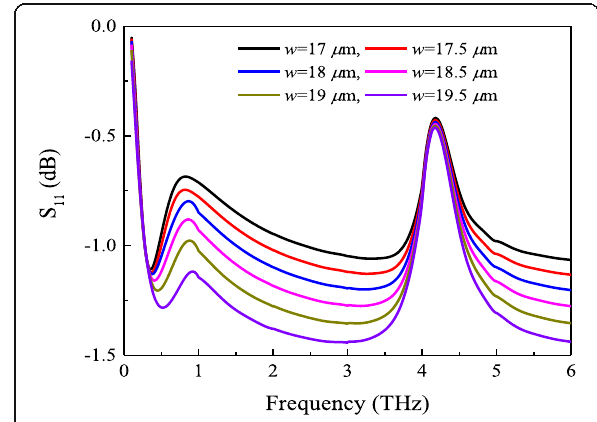
Fig. 6 Reflection coefficient of the metasurface-graphene absorber with the chemical potential μ c = 0.4